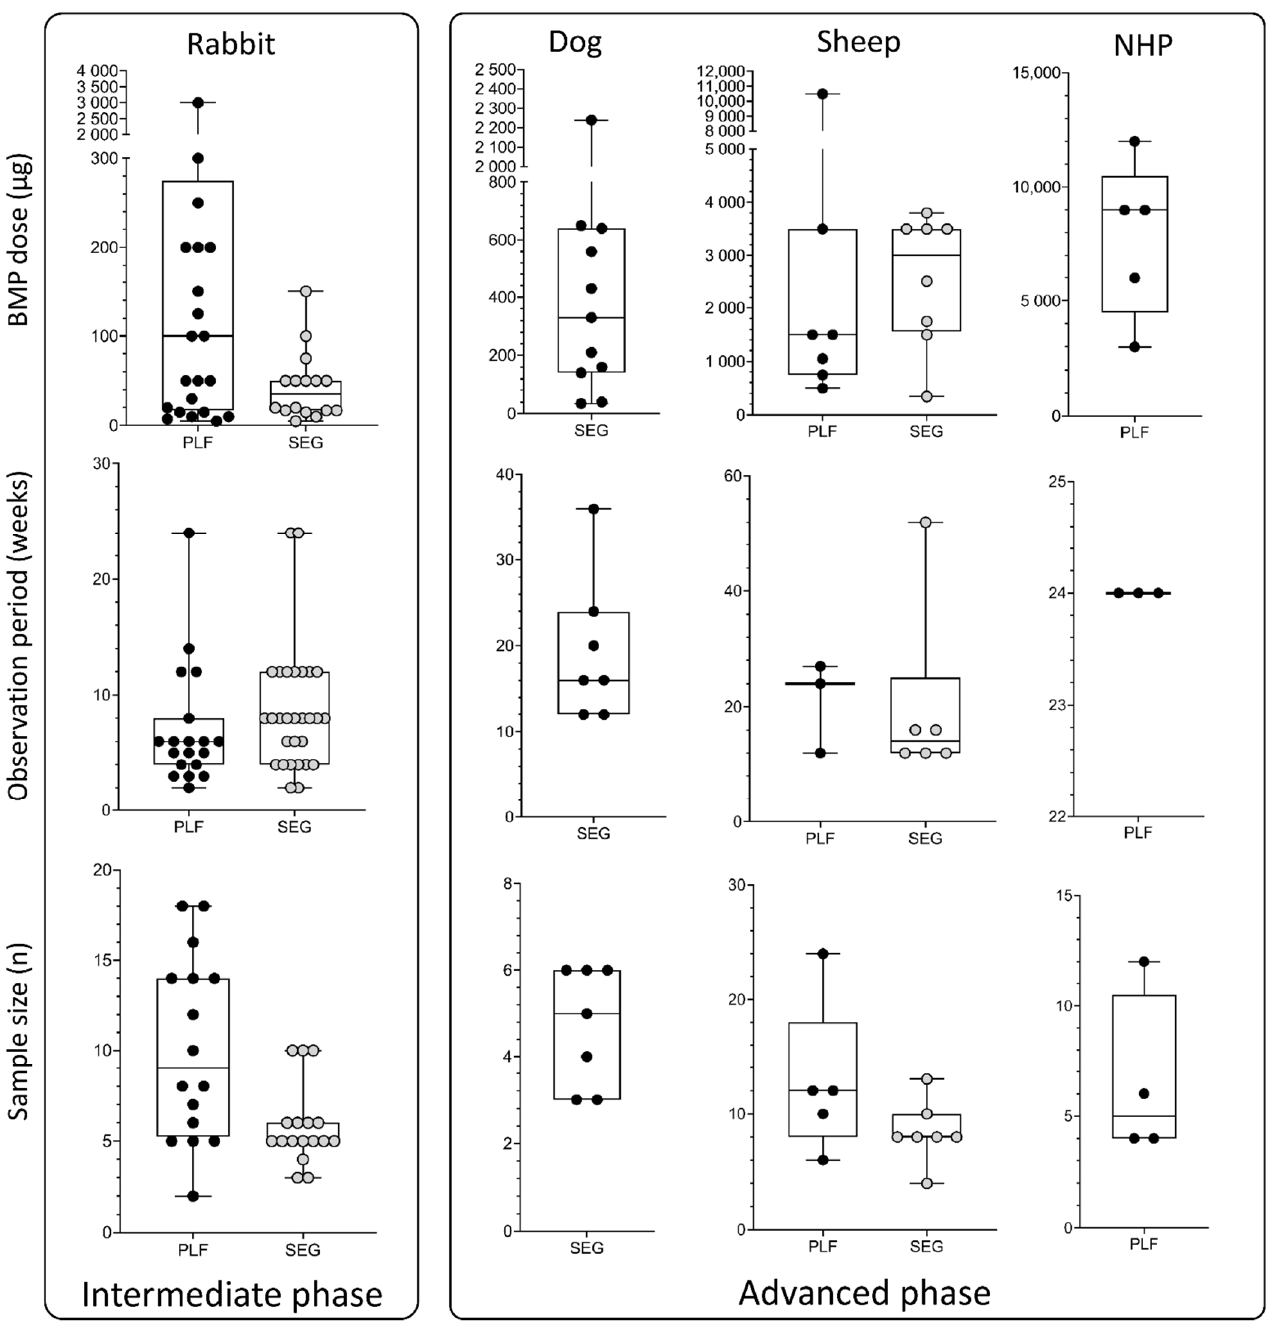
Figure 5. BMP doses (µg), observation period (weeks), and sample size ( n ) used in the intermediate and advanced phases, which include rabbit, dog, sheep, and non-human primate models. Data are presented through box and whisker plots in which dots represent all individual values from studies listed in Tables 3–6. SEG—segmental defect models; PLF— posterolateral spinal fusion model.